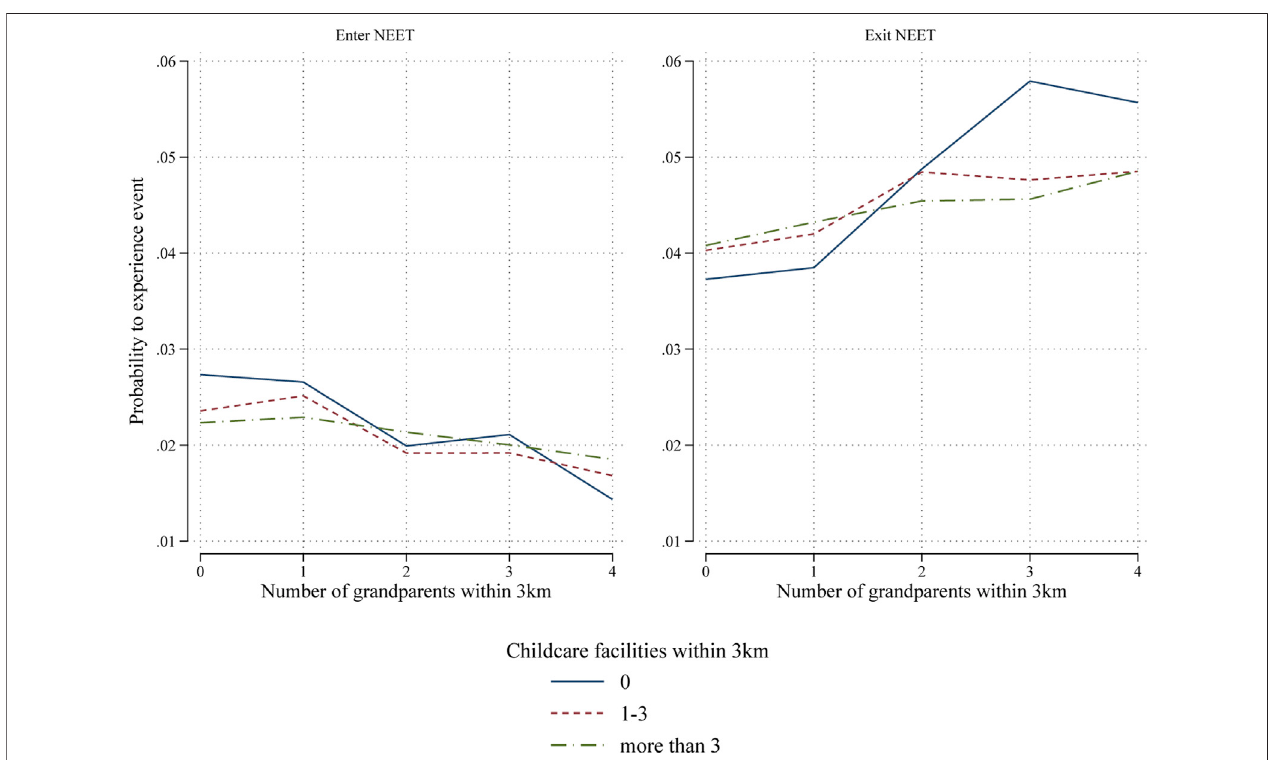
FIGURE 4 | Predicted probabilities of entering and exiting NEET for different levels of available formal and informal childcare support.